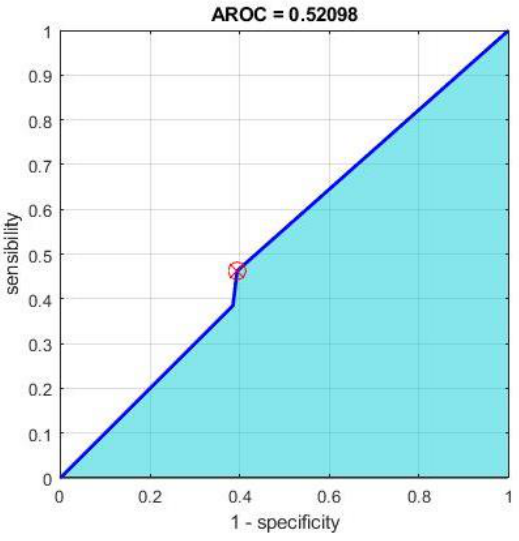
Figure 2. ROC curves to validate models of an initial urban area with simulated urban